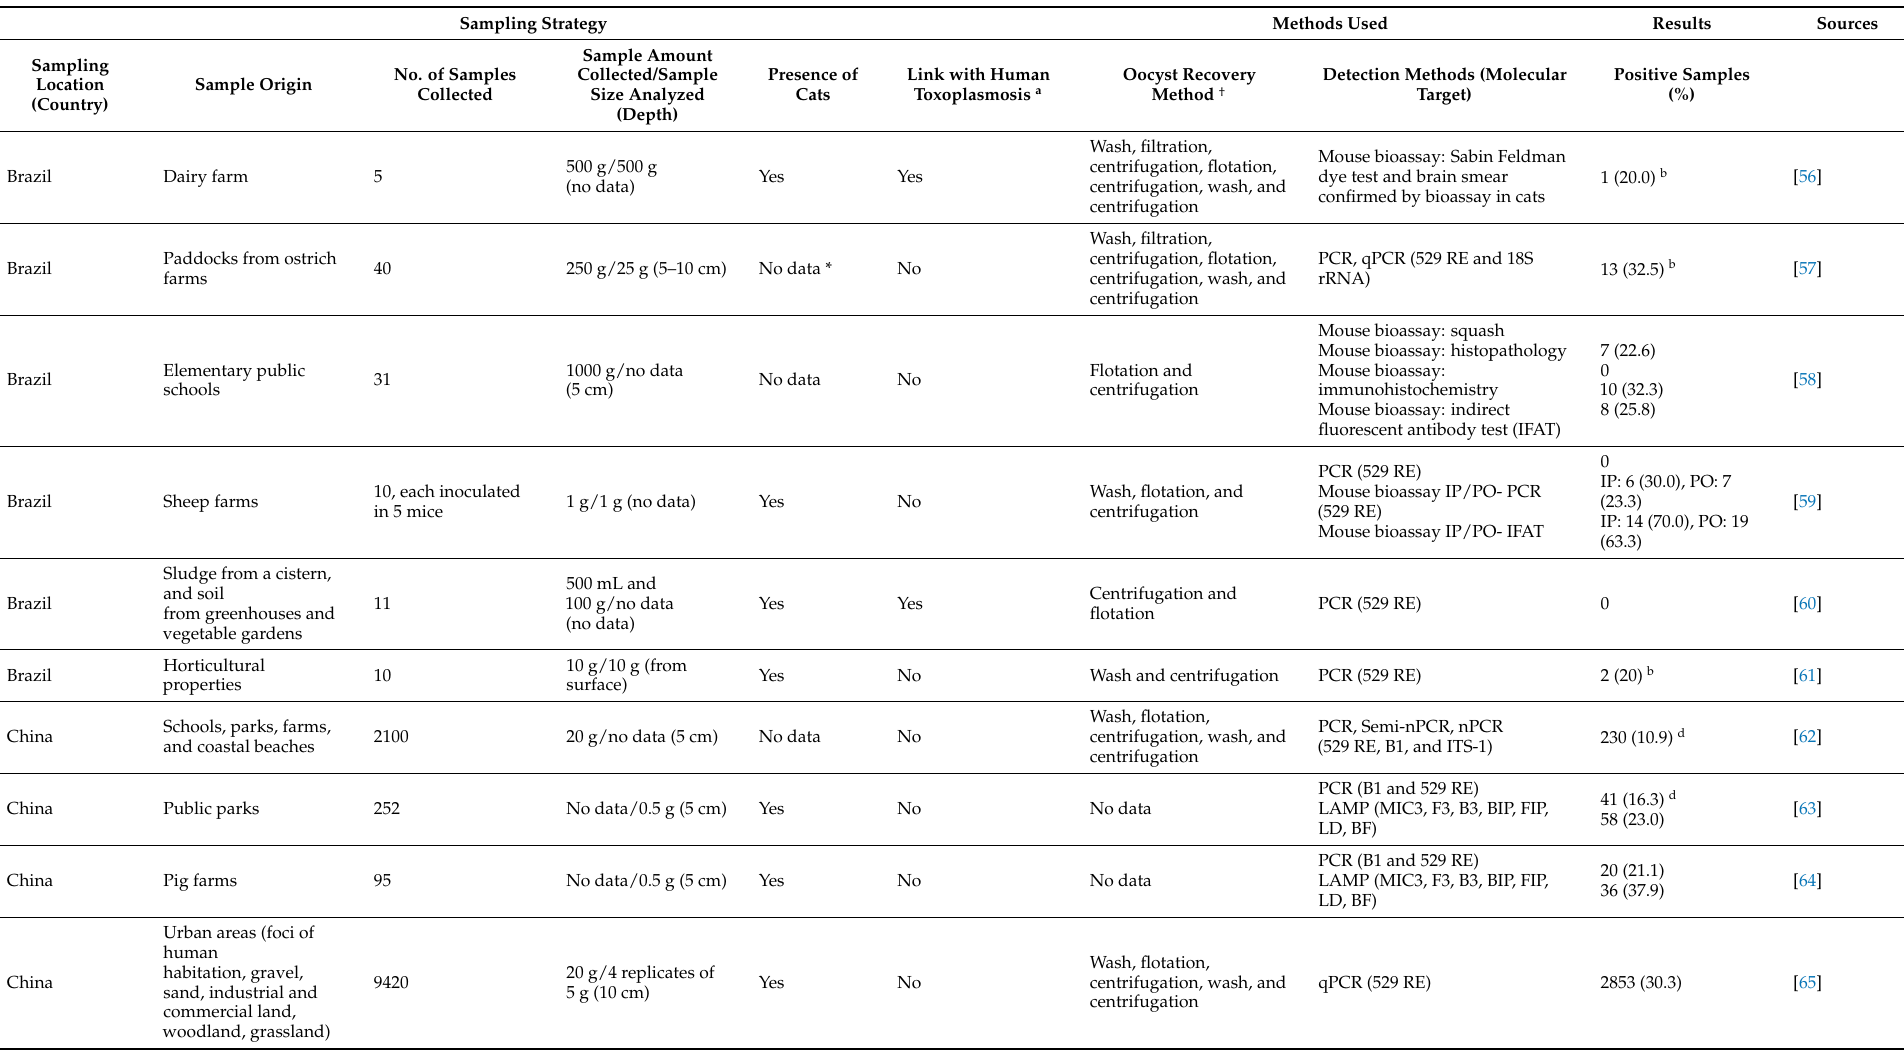
Table 1. Worldwide detection of Toxoplasma gondii oocysts in soil based on molecular and bioassay methods in articles published up to the end of